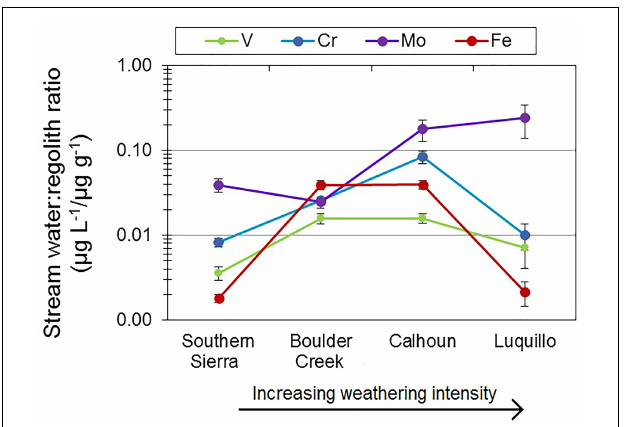
FIGURE 7 | Ratios of dissolved oxyanions in stream water to their respective concentrations in the least weathered regolith sample. Error bars are standard